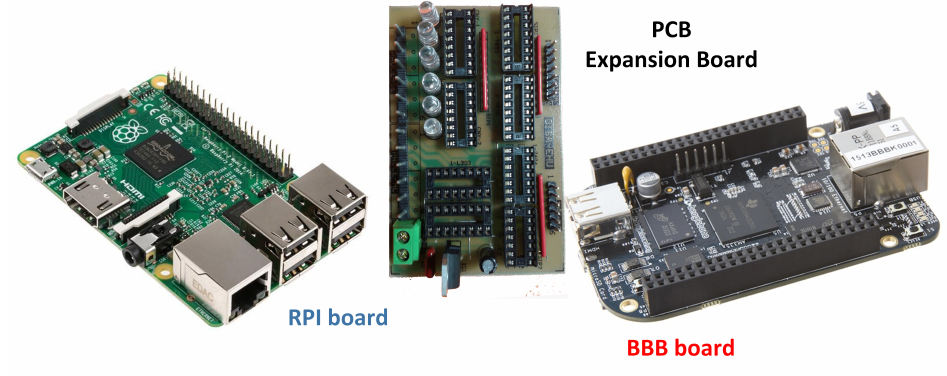
Figure 3. Hardware